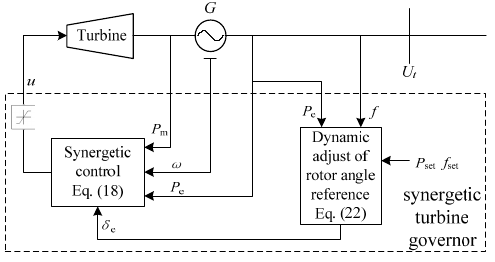
Figure 3. Block diagram of the proposed NSGC.